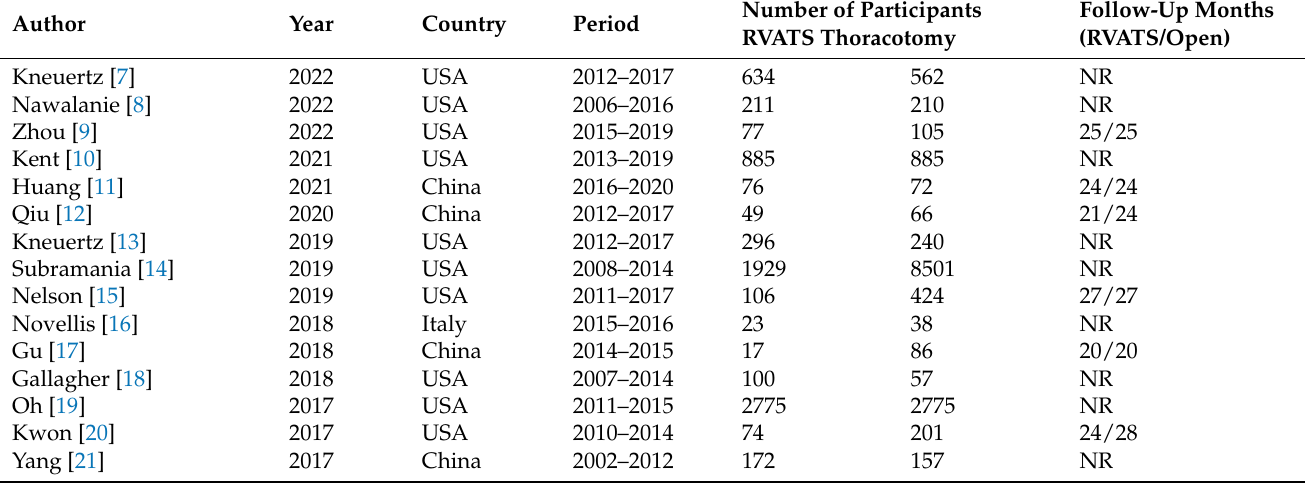
Table 1. Characteristics of studies comparing robotic video-assisted thoracoscopic surgery with open thoracotomy for patients with resectable non-small cell lung